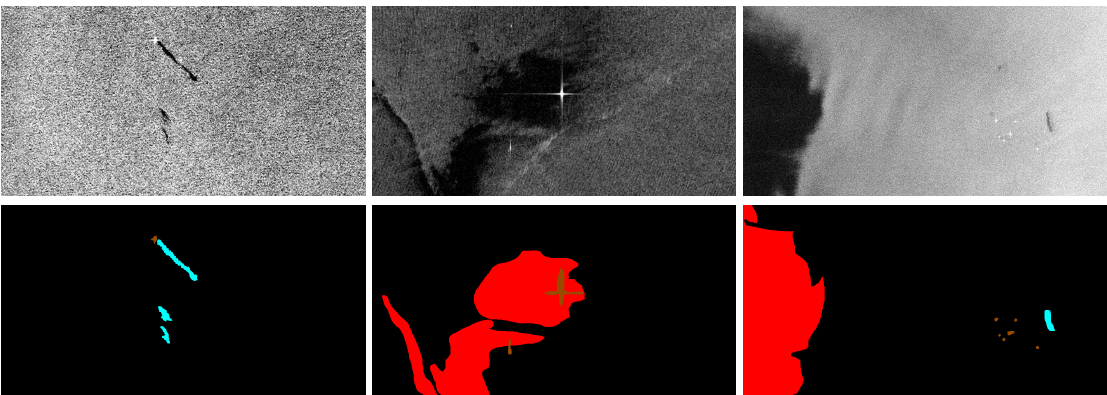
Figure 4. Sample SAR images and corresponding ground truth masks of oil spill dataset considered as plain